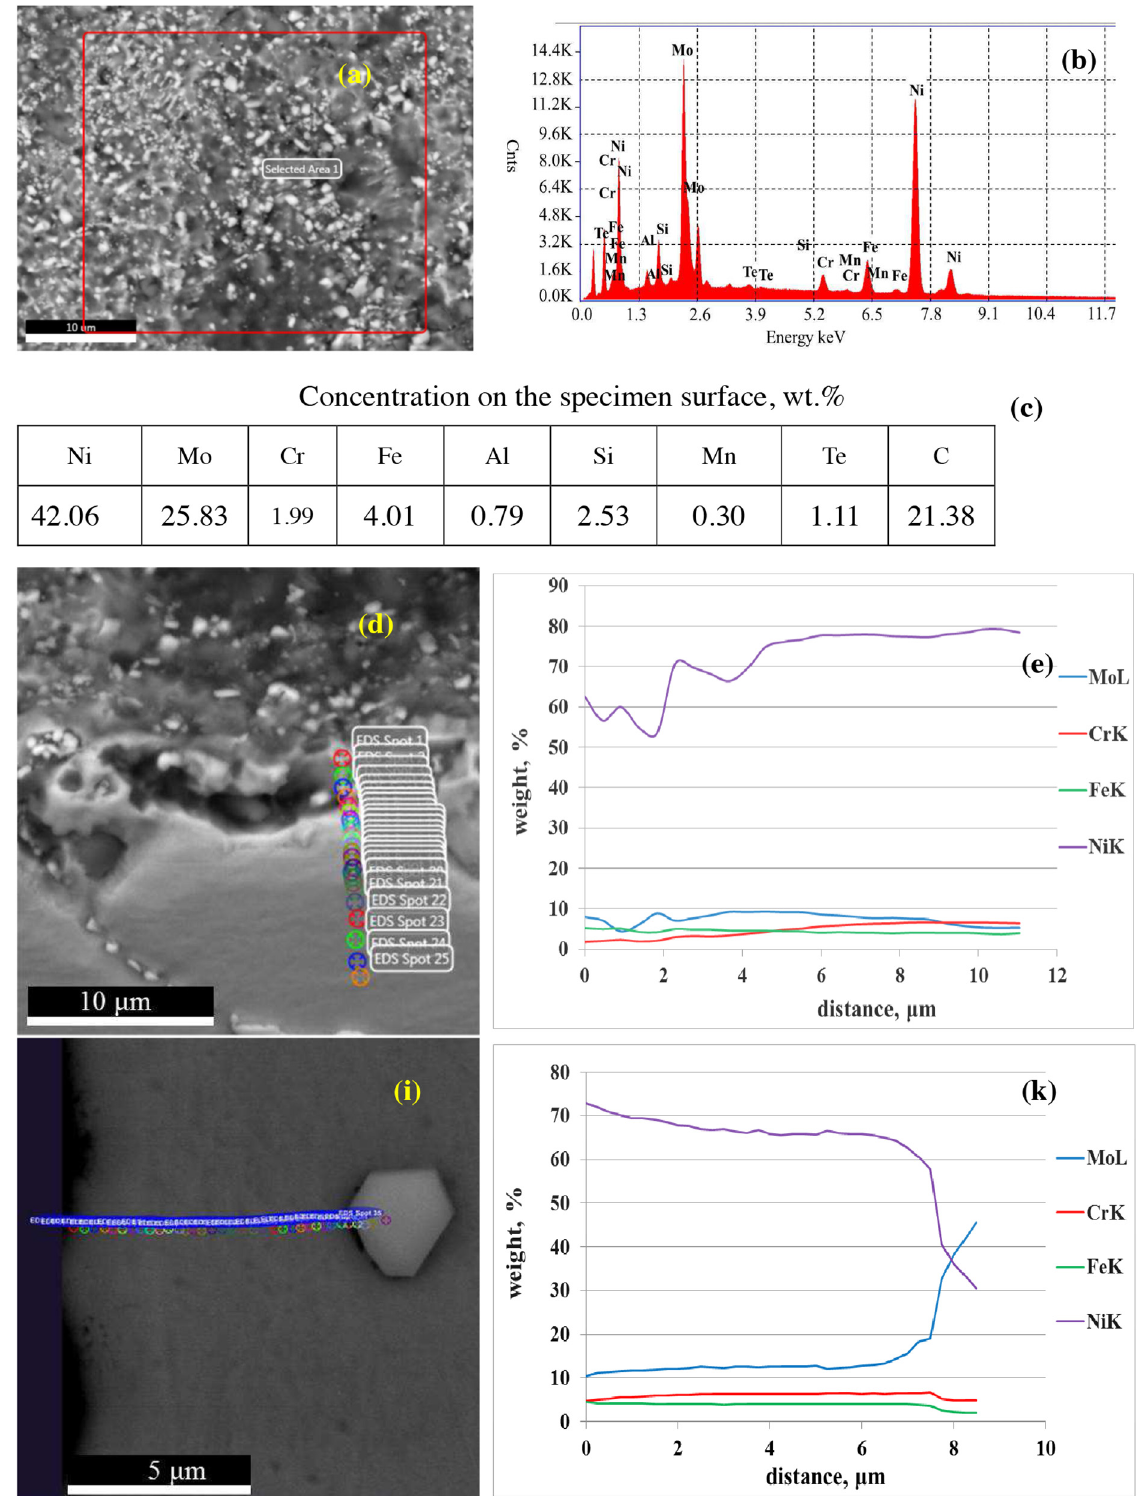
Fig. 6. Scanning data (scanning line and element composition) on allocated area from surface to grain depth of the Hastelloy-N alloy: (a) – (d) after exposure at T =800 ° C with [U(IV)]/[U(III)] ratio= 85, (i) and (k) after exposure at T =760 ° C with [U(IV)]/